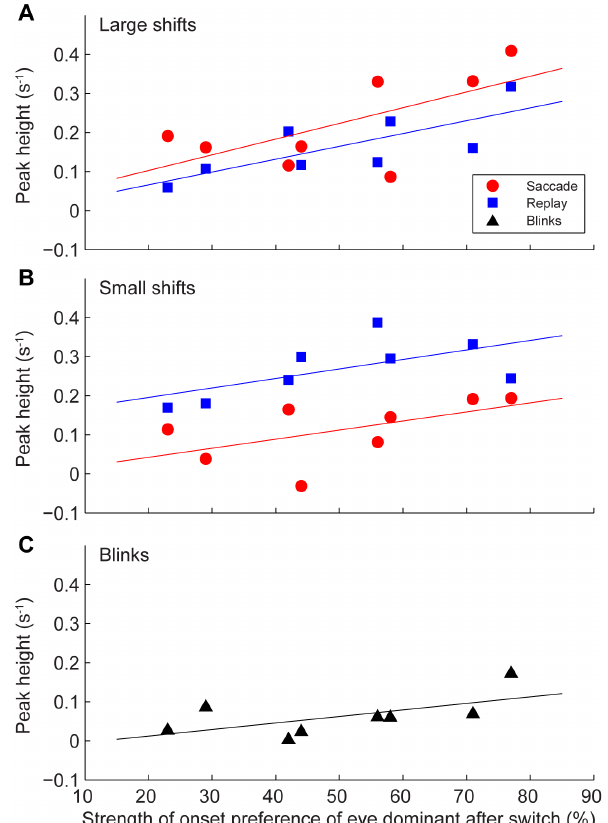
Figure 8. Peak value of the covariogram as function of onset preference strength. A: large retinal image shifts. B: small retinal image shifts. C: blinks. Peaks were determined as the maximal shift rate in the interval from 1.5 to 0.25 s before the button press and plotted against the onset preference of the eye that became dominant after the switch. Linear regression lines show least squares fits to the data.